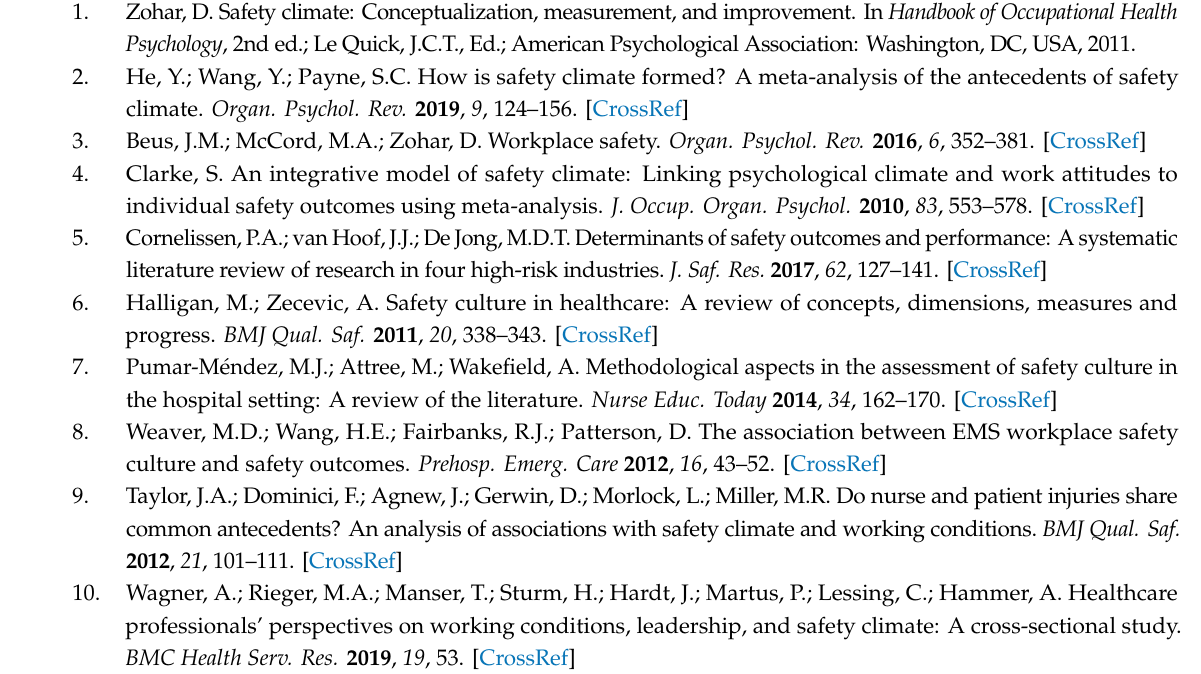
Table S1: Modified PRISMA checklist according to Moher et al. 2009 [22]; Table S2: Example for search strategy in Pubmed: Text word search; Table S3: Example for search strategy in Pubmed: MeSH-Tetablerm search; Table S4: Quality appraisal items; Table S5: Overview of the study characteristics and mapping the clusters according to Cornelissen et al.